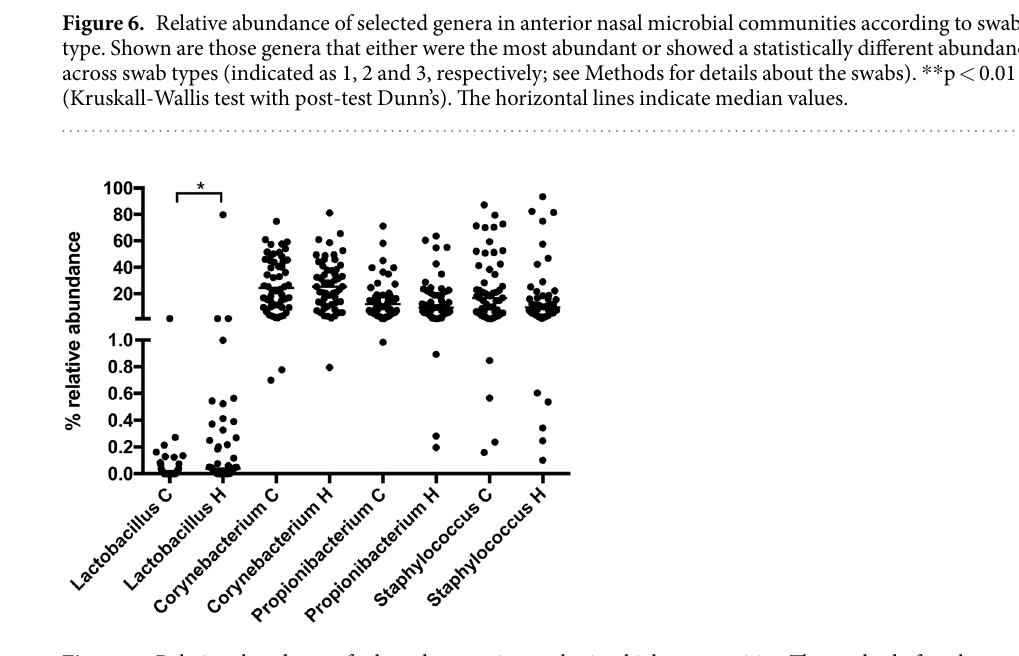
Figure 7. Relative abundance of selected genera in nasal microbial communities. The method of swab collection is indicated on the x-axis: collected in the study center = C; collected at home = H. Only samples that had a perfect match in participant age and sex were considered (54 samples each). Statistically significant differences in genus abundances between samples taken at home by study participants (H) and by certified study personnel at the study center (C) were calculated by the Mann Whitney U test, * p < 0.05; *** p < 0.001. Median values are indicated by the horizontal